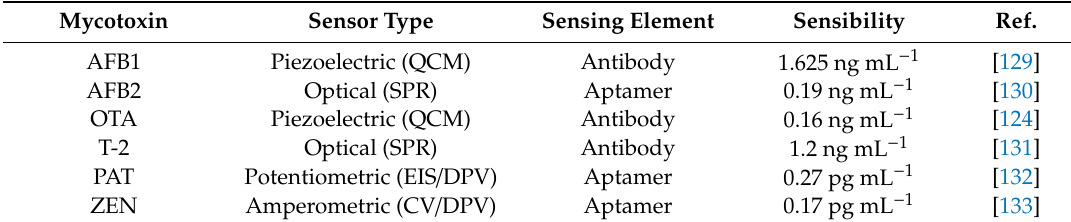
Table 2. Recent application of biosensors for mycotoxin contamination mainly in foodstu ff